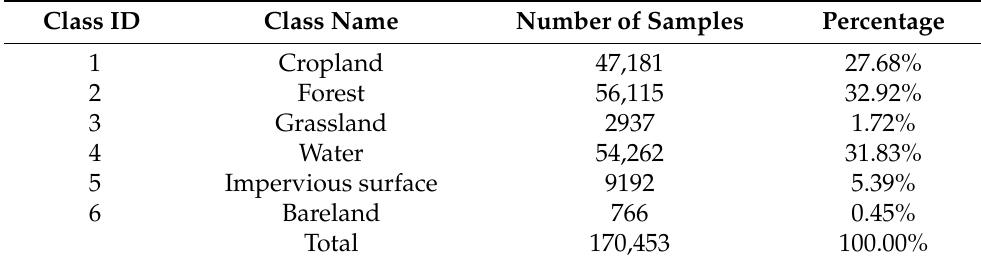
Figure 8. Temporal distribution of satellite images in the Poyang Lake dataset. Table 4. Class Ddistribution of the reference set of Poyang Lake dataset.